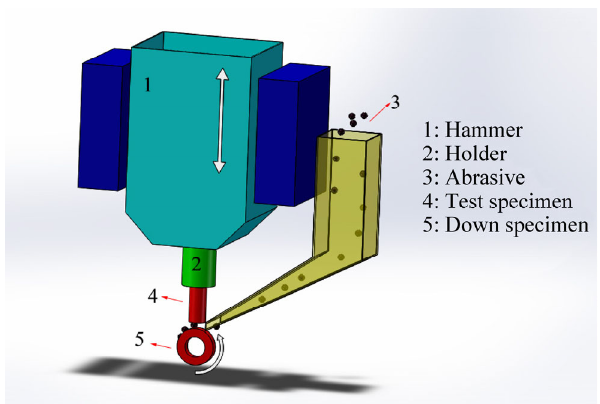
Fig. 1 Structure of the